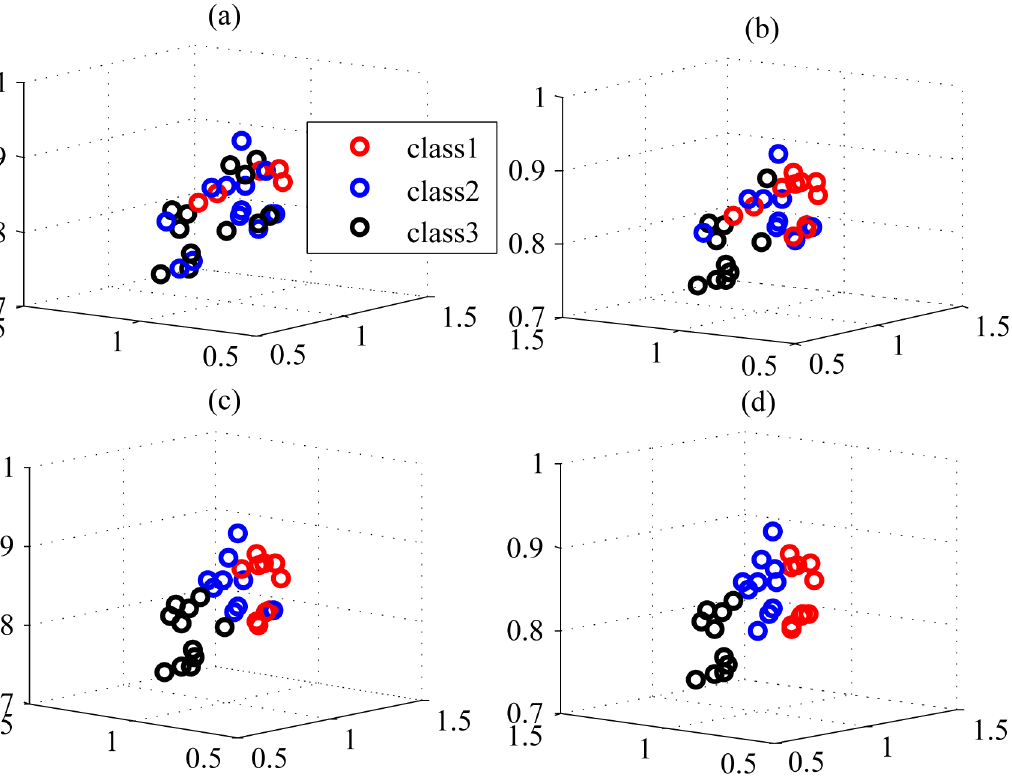
Fig 2. The toy example illustrating the labeling results obtained from the coefficients when the propagation procedure arrives at the (a) initialization stage, (b) 50-th iteration round, (c) 300-th iteration round, and (d) the resultant convergence (1500-th iteration round), respectively.